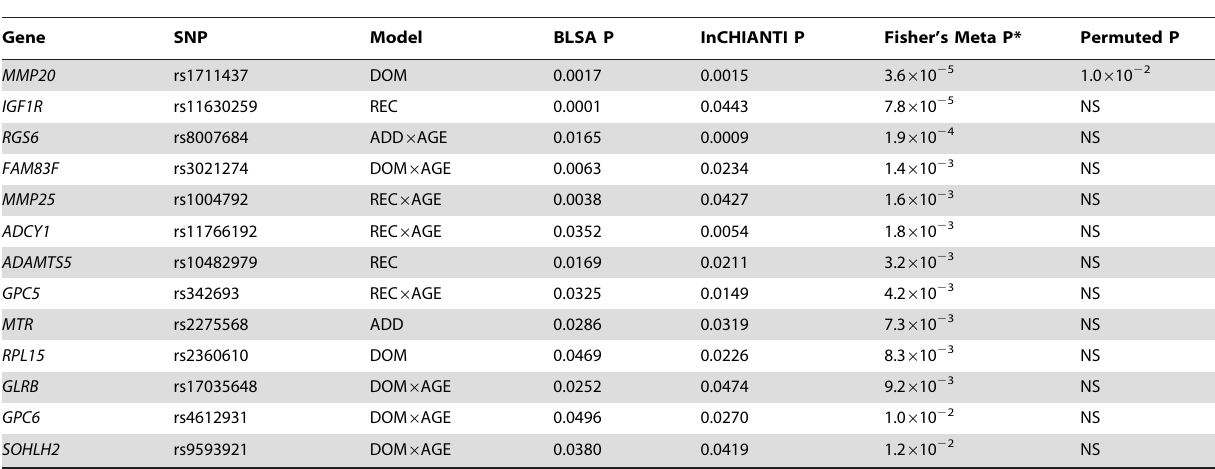
Table 2. Top SNPs that show association with kidney aging in two populations.